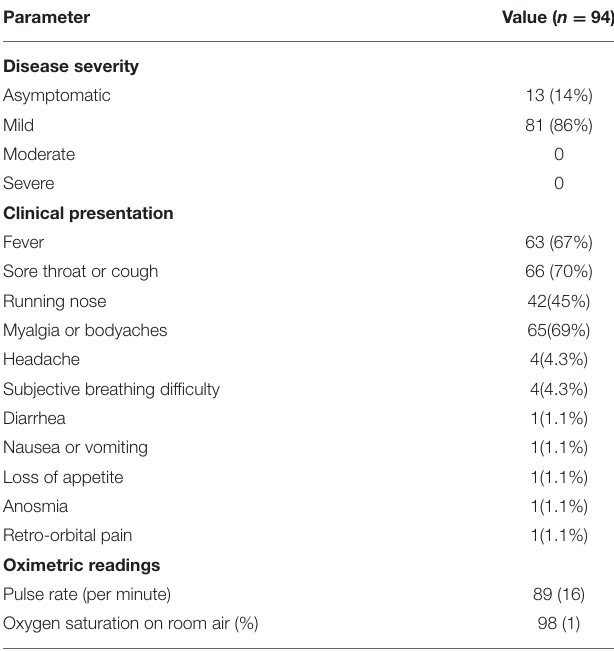
TABLE 2 | Clinical details of the current COVID-19 infection in the included patients. Parameter